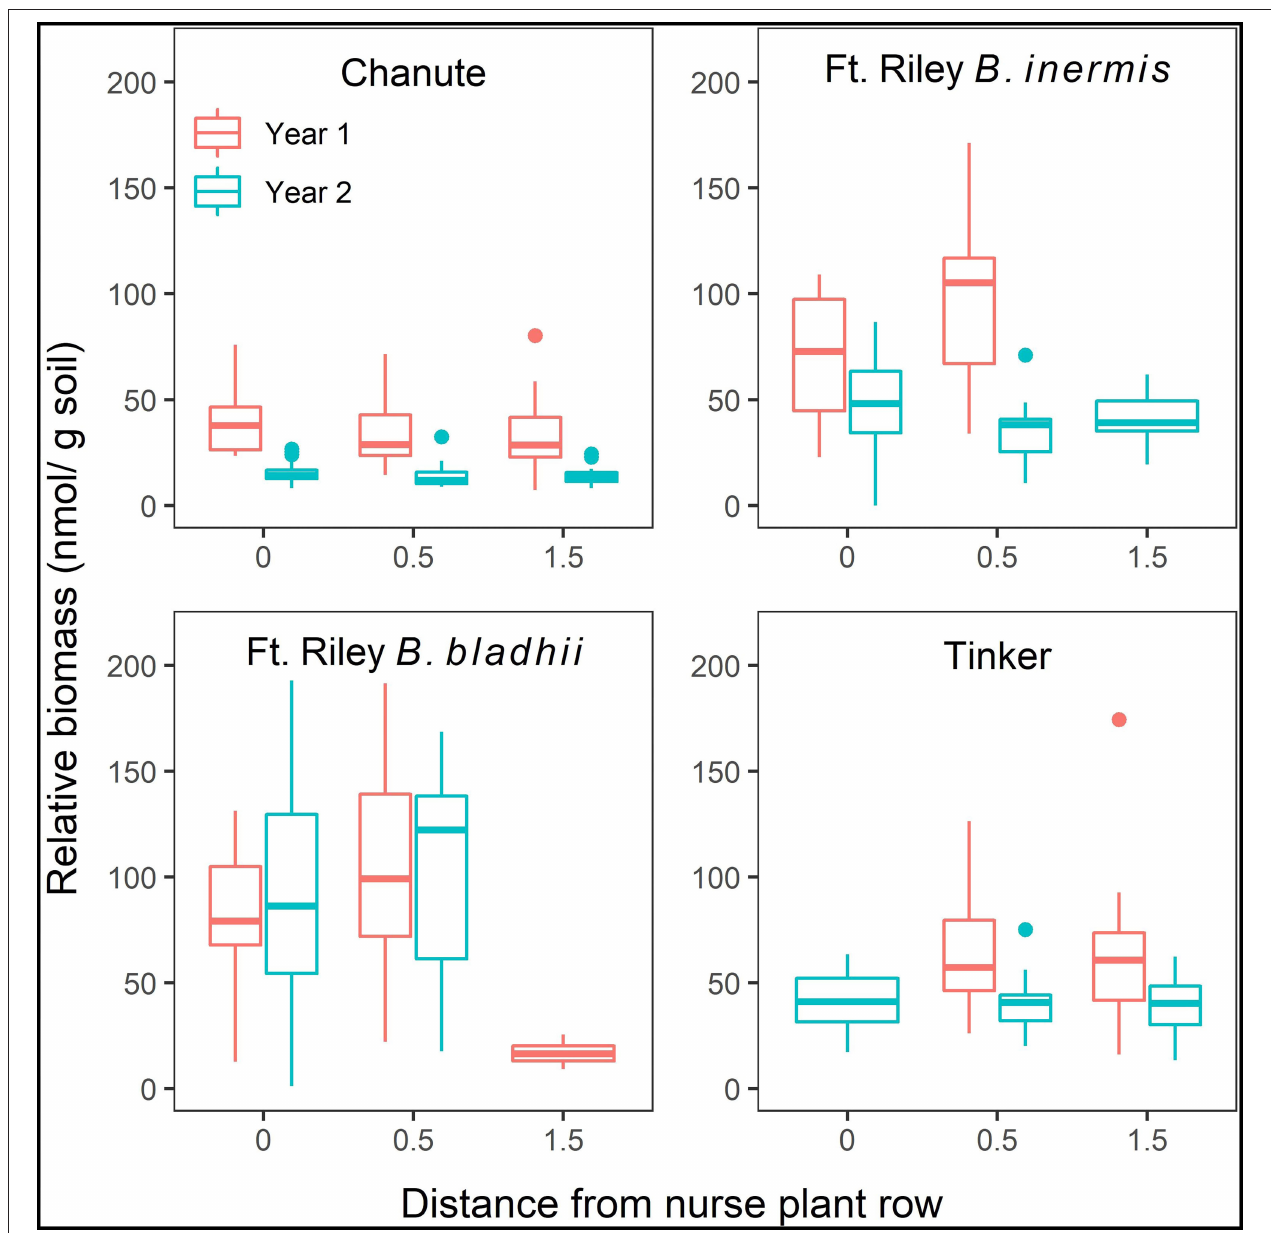
FIGURE 5 | The effects of site, distance from nurse plant row (X-axis), and year on relative abundances of extra-radical arbuscular mycorrhizal (AM) fungi (mean ± SE) measured through NLFA. Red bars represent measurements from year 1, and blue bars represent measurements from year 2.